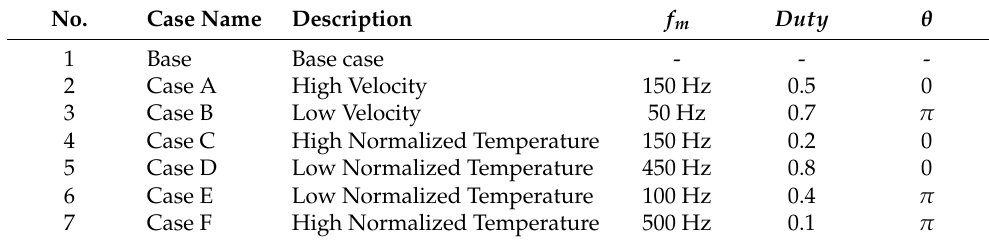
Table 2. Denoted cases regarding Modular Frequency, Duty, and Phase Difference.